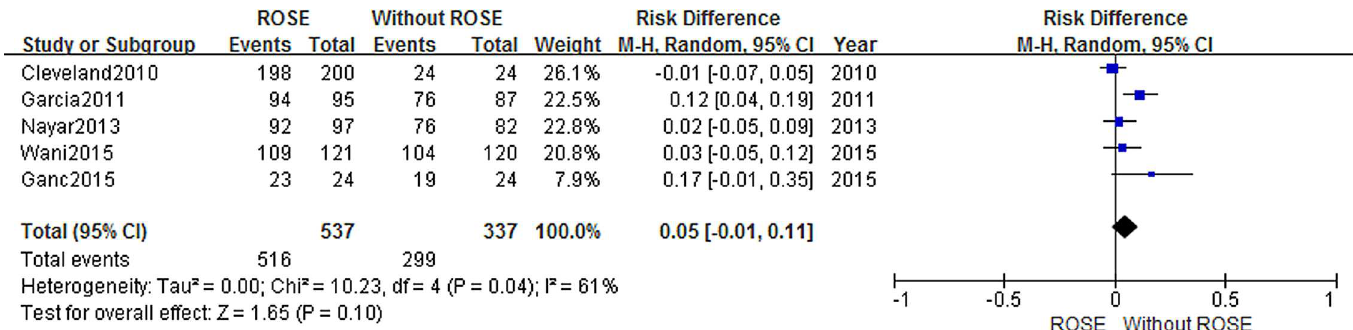
(Fig 8). The symmetric curve shows a trade-off between sensitivity and specificity. The area under the SROC was 0.99 and 0.96 for the ROSE group and non-ROSE group, which indicated high accuracy.